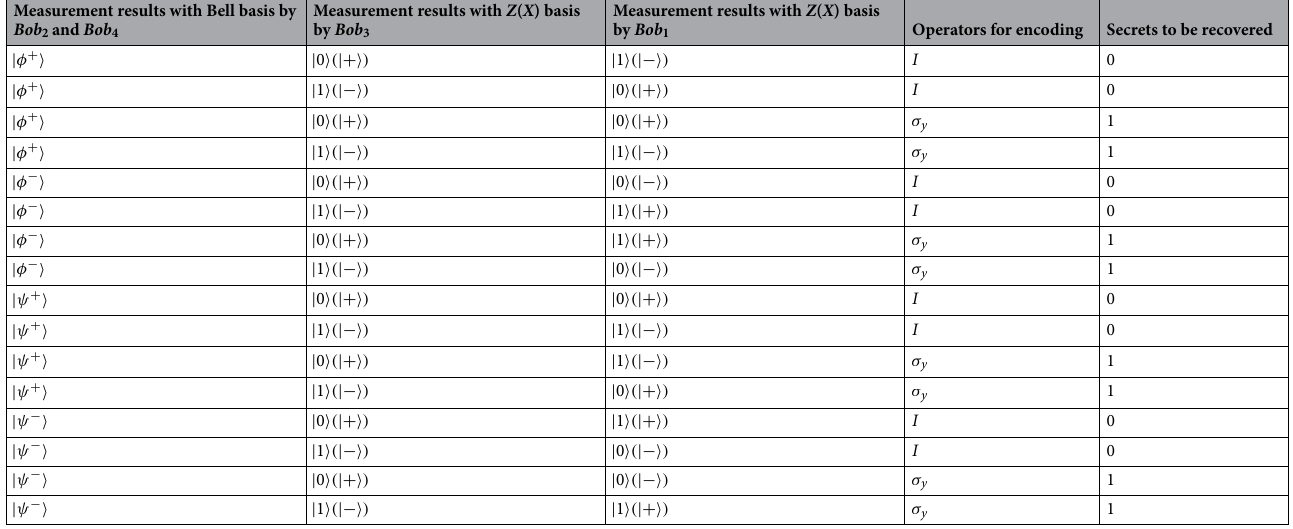
Table 3. Bob 2 , Bob 3 and Bob 4 can unite to recover the secret shared by Bob 1 through combining the Z ( X ) basis measurement by Bob 1 , the Z ( X ) basis measurement by Bob 3 and the joint measurements by Bob 2 and Bob 4